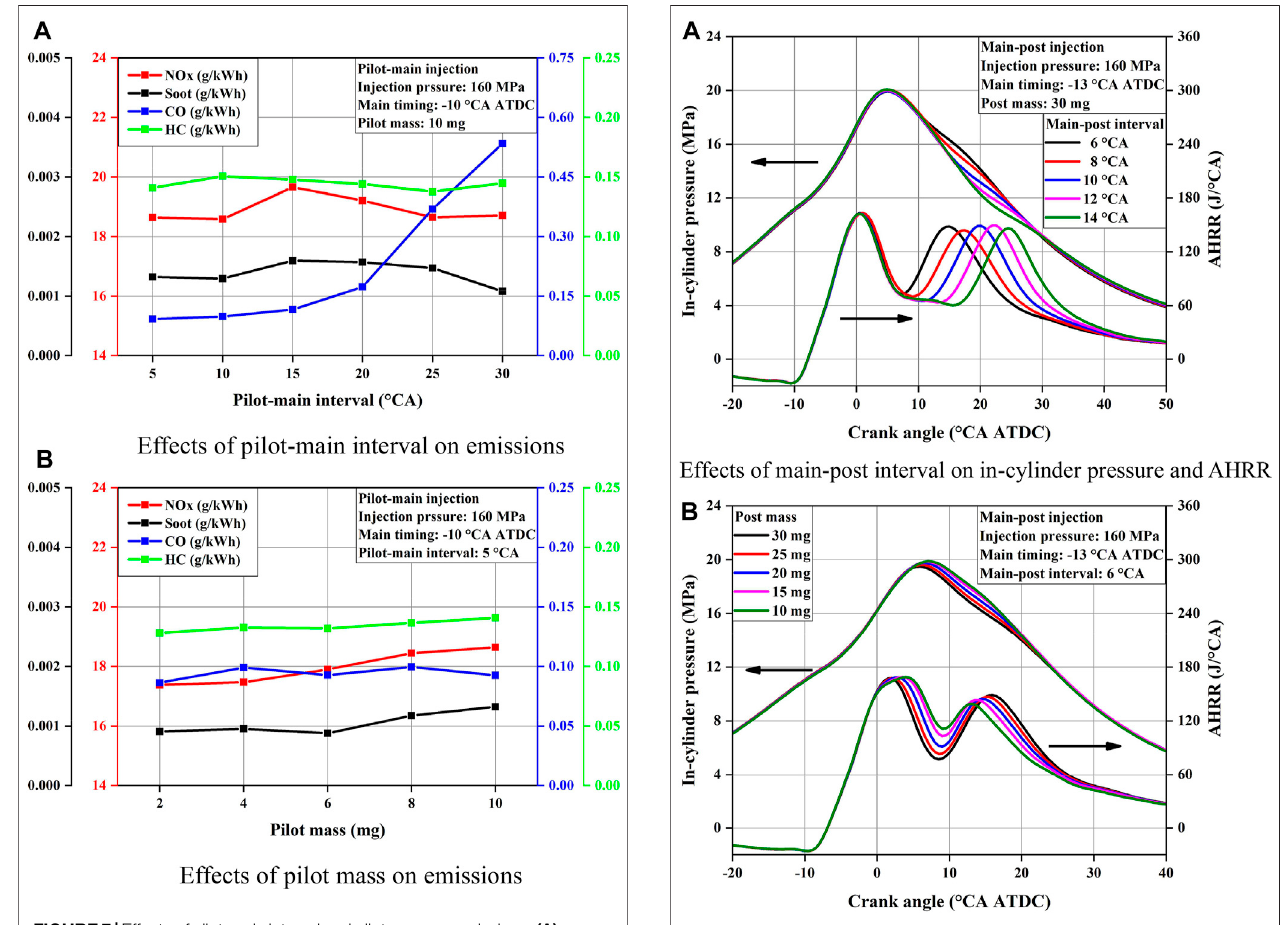
FIGURE 8 | Effects of main-post interval and post mass on combustion characteristics. (A) Effects of main-post interval on in-cylinder pressure and AHRR, (B) Effects of post mass on in-cylinder pressure and